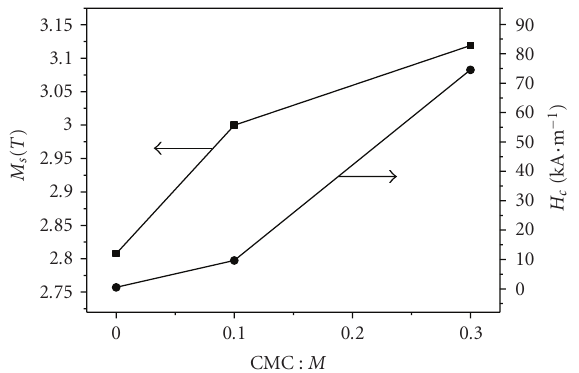
Figure 5: Variations of saturation magnetisation and coercivity with molar ratio of CMC monomer: metal ions (CMC